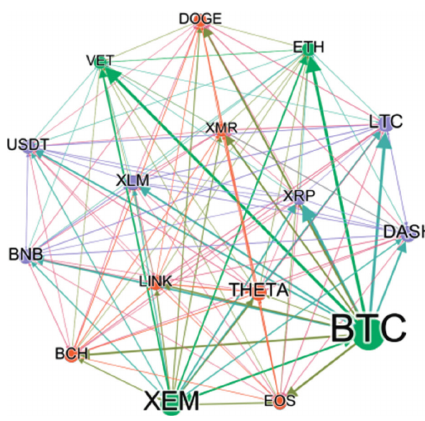
Figure 27: Risk spillover under D2.